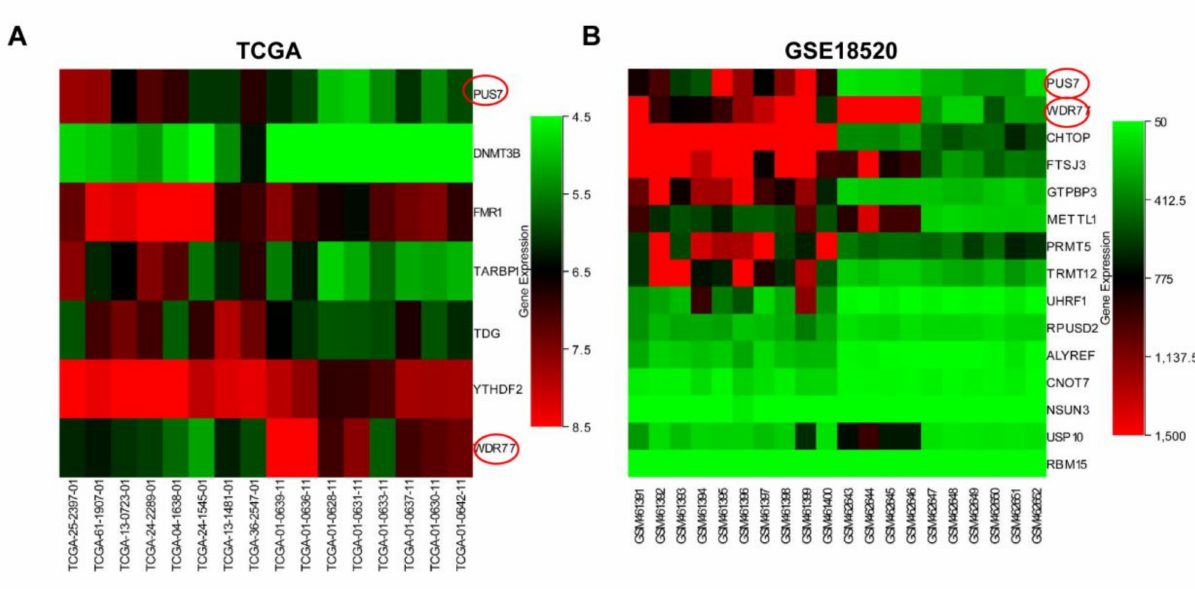
Figure 2. The heatmaps of differentially expressed RMGs. ( A ) The heatmap of the expression profile of overlapping genes of RMGs and DEGs in normal tissues and OV tissues in the TCGA dataset. ( B ) The heatmaps of the expression profile for overlapping genes of RMGs and DEGs in normal tissues and OV tissues in the GSE18520